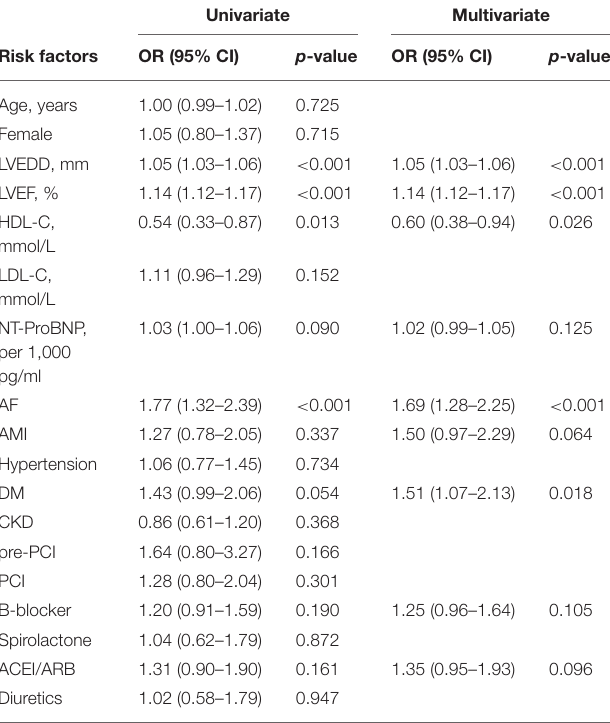
TABLE 3 | The univariate and multivariate logistic regression analysis of worsening LVEF. Univariate